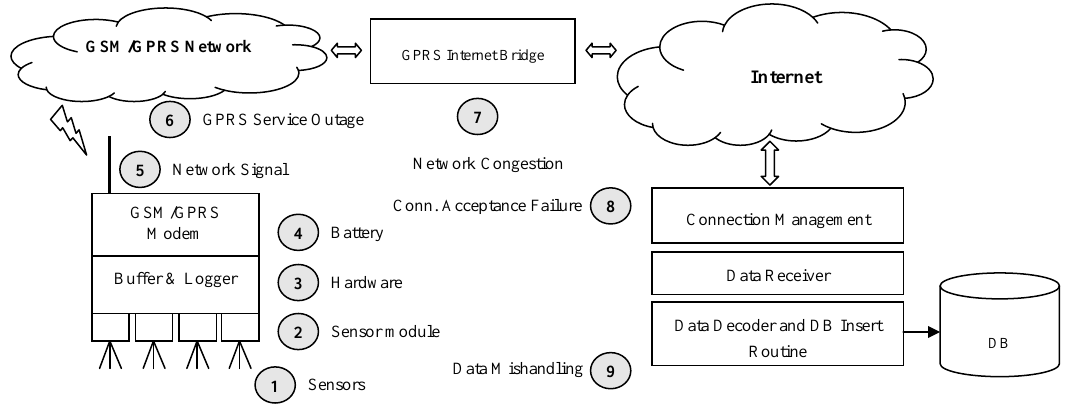
Figure 1. The diagram outlines the configuration of the sensor network being investigated. An abstracted view of the process is captured to maintain clarity. Circled numbers indicate possible failure points within the infrastructure which are relevant to the analysis.